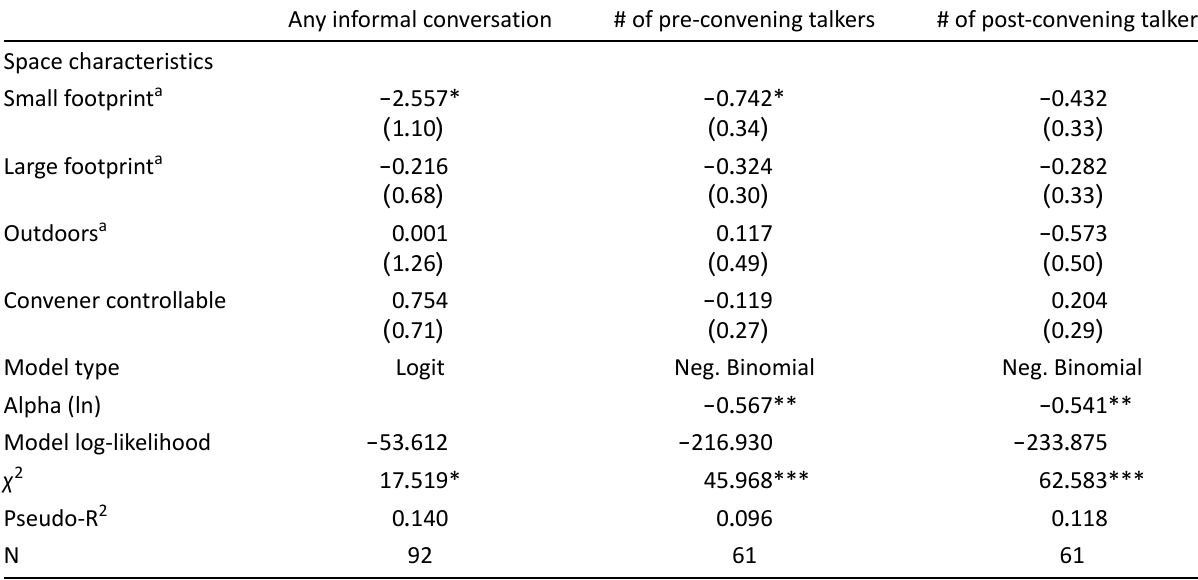
Table 2. Estimated effects of space characteristics on conversational